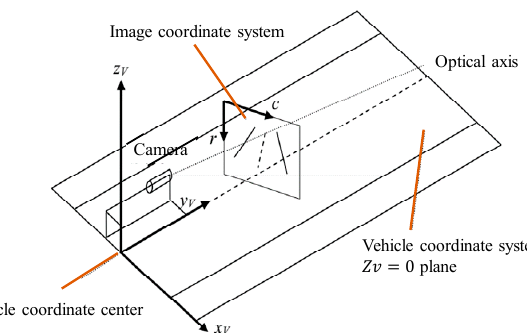
Figure 2. The principles of the inverse perspective transformation.